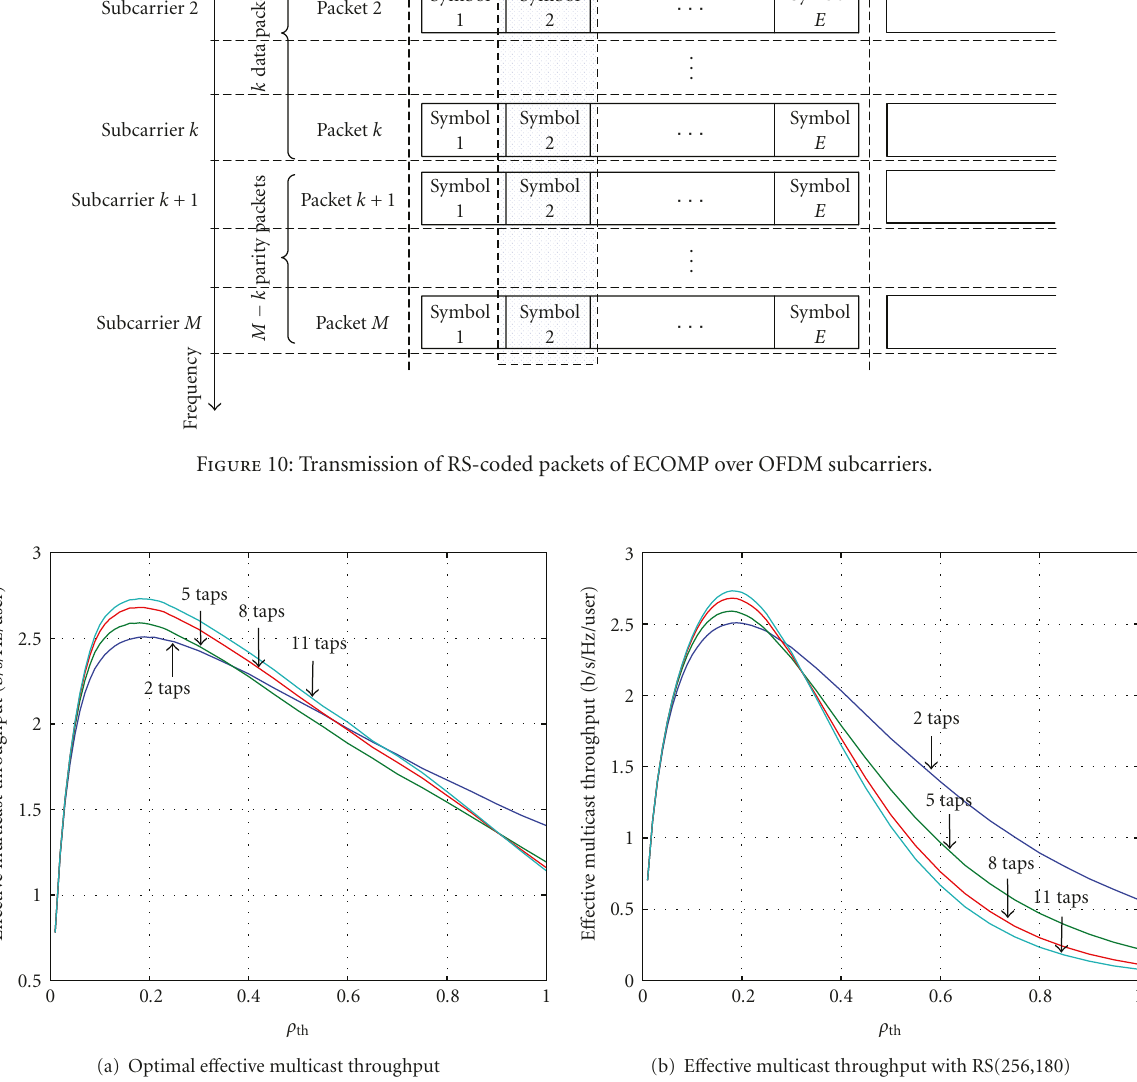
Similar to the performance comparison in Section 2, BU is better than WU in the low SNR region while WU outper- forms BU after the crossover point of around 5 dB. Combin-